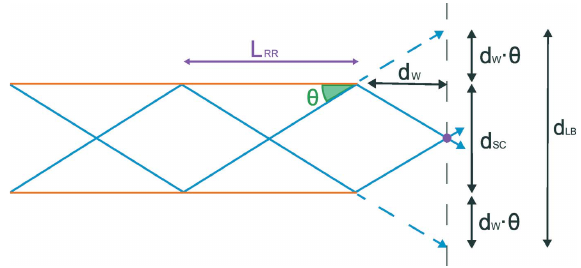
Figure 5 Multiple reflections and estimates of a lower boundary for the spot size close to the focal distance of a straight monocapillary